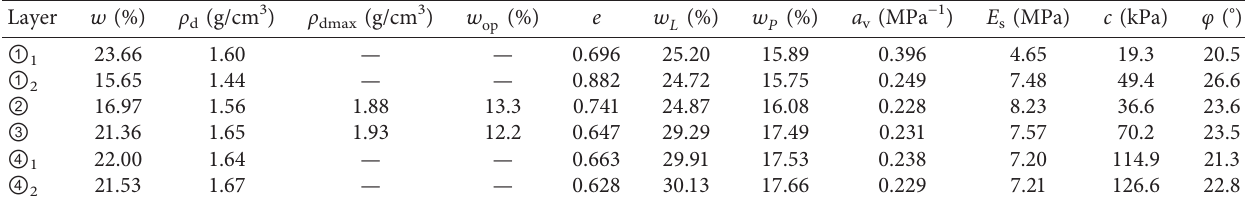
Table 2: Mean values of physical and mechanical parameters of soil samples.